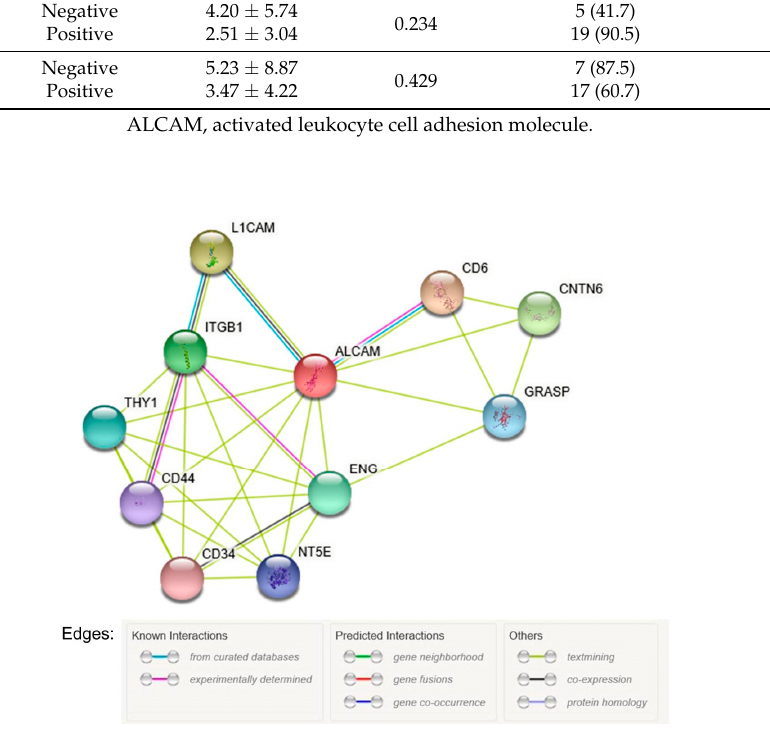
Figure 1. Protein-protein interaction network of ALCAM constructed with STRING version 10.5, ALCAM, activated leukocyte cell adhesion molecule.